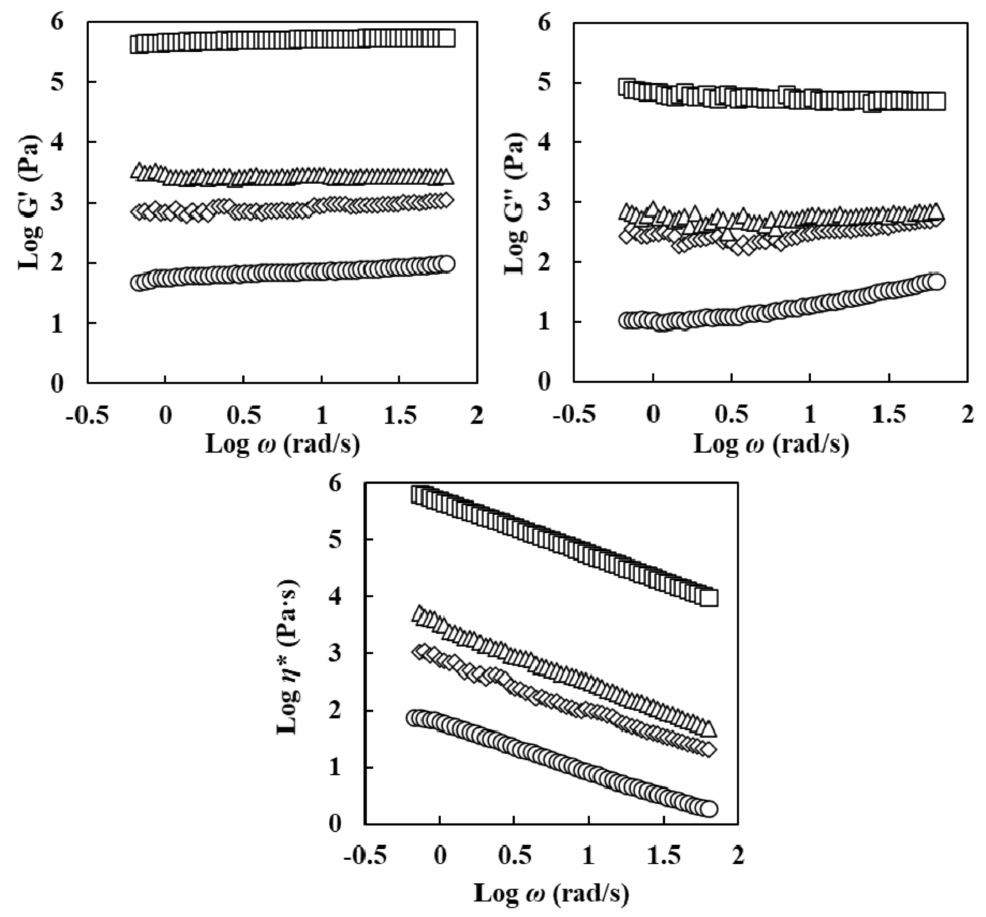
Figure 5. Log storage modulus (G (cid:48) ), log loss modulus (G (cid:48)(cid:48) ), and log complex viscosity ( η * ) vs. log angular frequency ( ω ) for oleogels prepared with different concentrations of esterified rice flour with citric acid (ERCA). ( (cid:35)